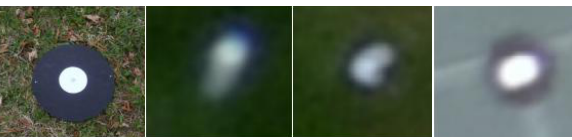
Figure 8. The original target (left) and the corresponding targets in the image with motion blur